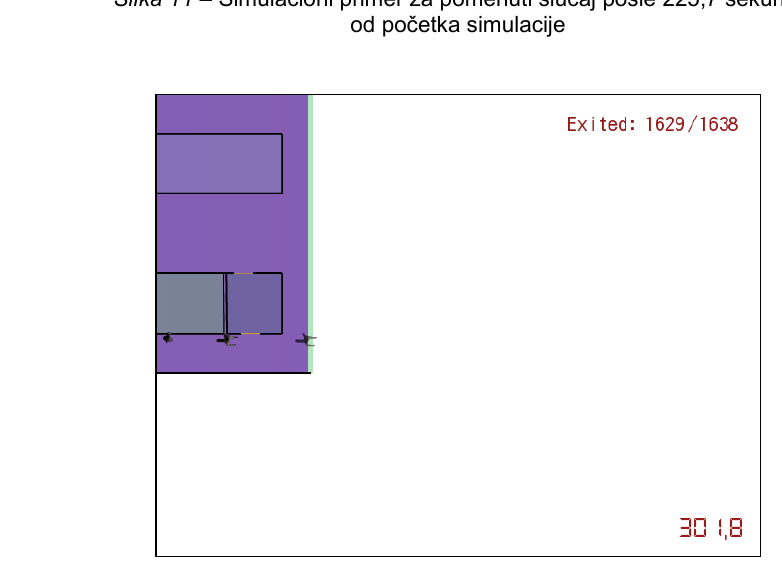
Figure 12 – The simulation example for the noted case at the exit/entrance of the tunnel after 301.8 seconds from the start of the simulation Рис . 12 – Симуляционный пример приведенного случая спустя 301.8